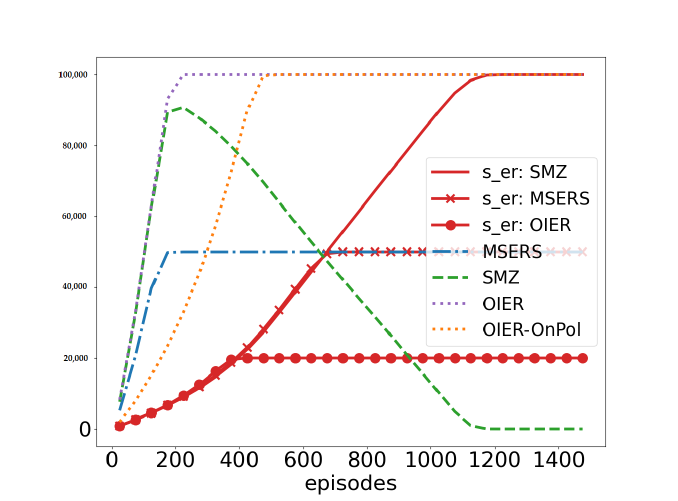
Figure 10. The intuition of Interpolated Experience Replay memory for the LKE state encoding and t expl =